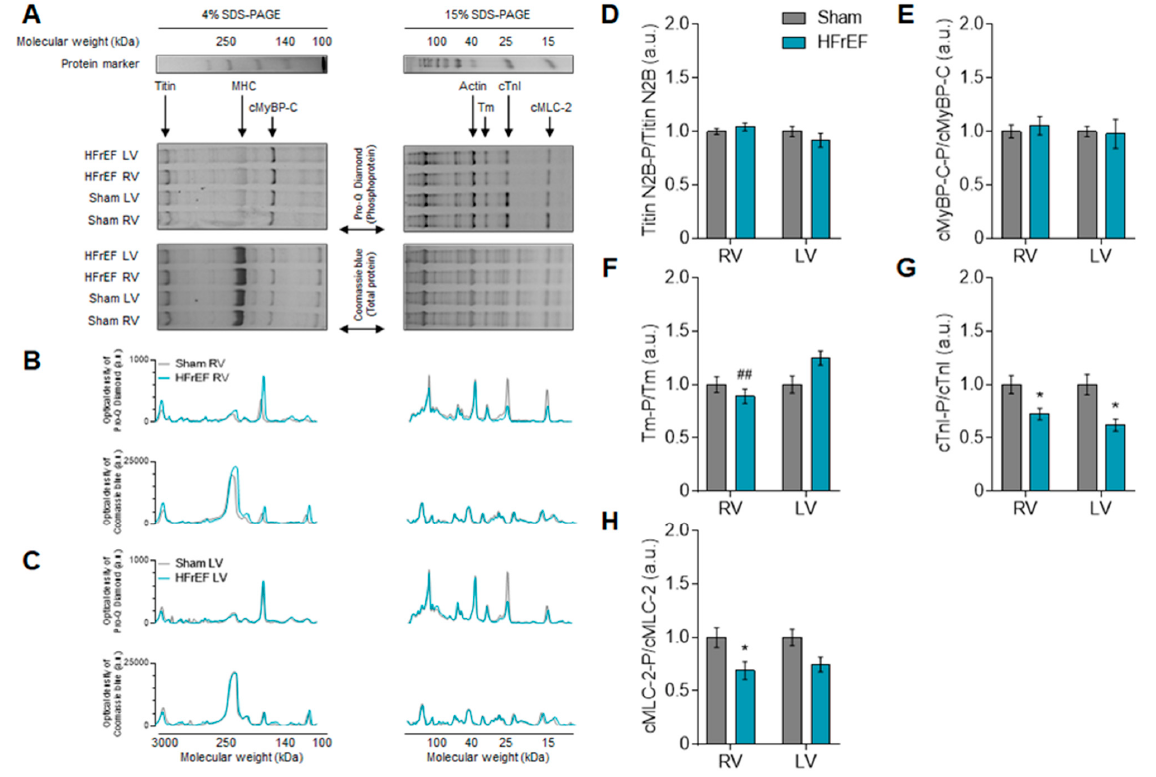
Figure 6. Overall myofilament protein phosphorylation patterns of the RV and the LV in the post-ischemic rat heart. Collection of contractile protein bands in each group is shown by phosphoprotein and protein gel staining of 4% and 15% gels ( A ). SDS-PAGE indicates 1D polyacrylamide gel electrophoresis; MHC, myosin heavy chain; cMyBP-C, cardiac myosin binding protein-C; Tm, tropomyosin; cTnI, cardiac troponin I; MLC-2, myosin light chain 2. Corresponding representations of optical densities of protein gel staining in the RV ( B ) and the LV ( C ) are given in arbitrary units (a.u.). Phosphorylation of titin ( D ), cMyBP-C ( E ), Tm ( F ), cTnI ( G ), and cMLC-2 ( H ) are shown as phosphoprotein/total protein ratios. Data are shown as mean ± SEM; panel D: n = 23–47 SDS-PAGE/3–5 heart/group; panels E-H: n = 8–20 SDS-PAGE/3–5 heart/group. * p < 0.05 HFrEF vs. Sham (same ventricle); ## p < 0.01 RV vs. LV (same group).